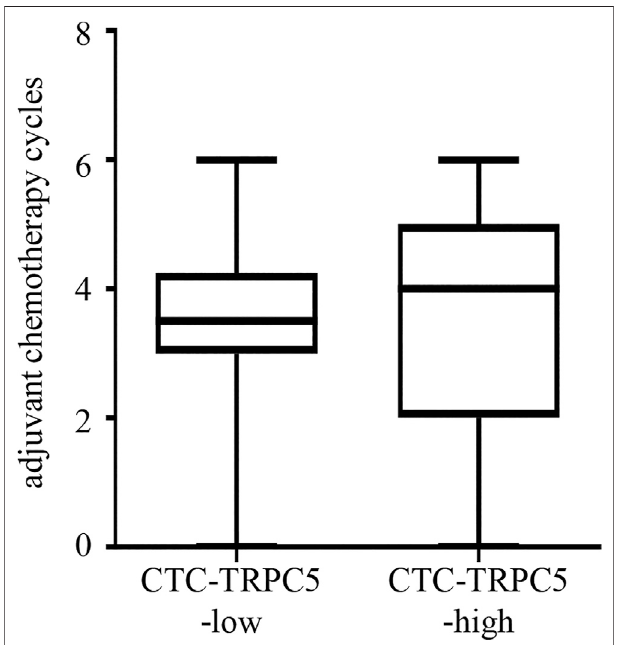
FIGURE 4 | CTC-TRPC5 level was not signi fi cantly associated with the adjuvant chemotherapy